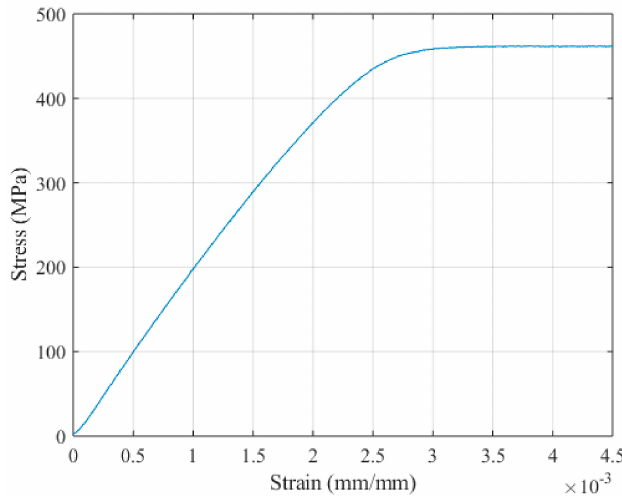
Figure 5. Experimental setup: ( a ) load frame, ( b ) reaction frame and specimen.